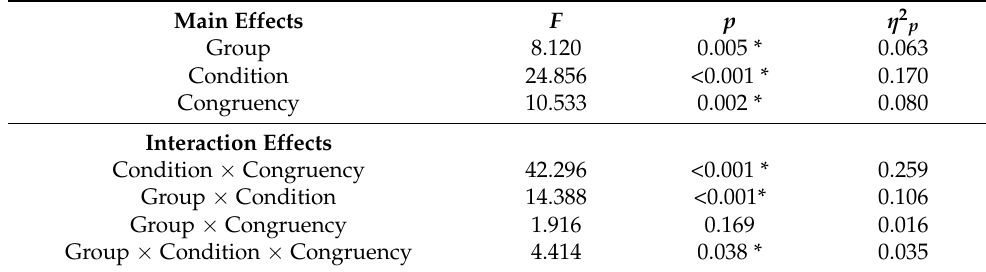
Table 3. Repeated-measure ANOVA results for main effects and